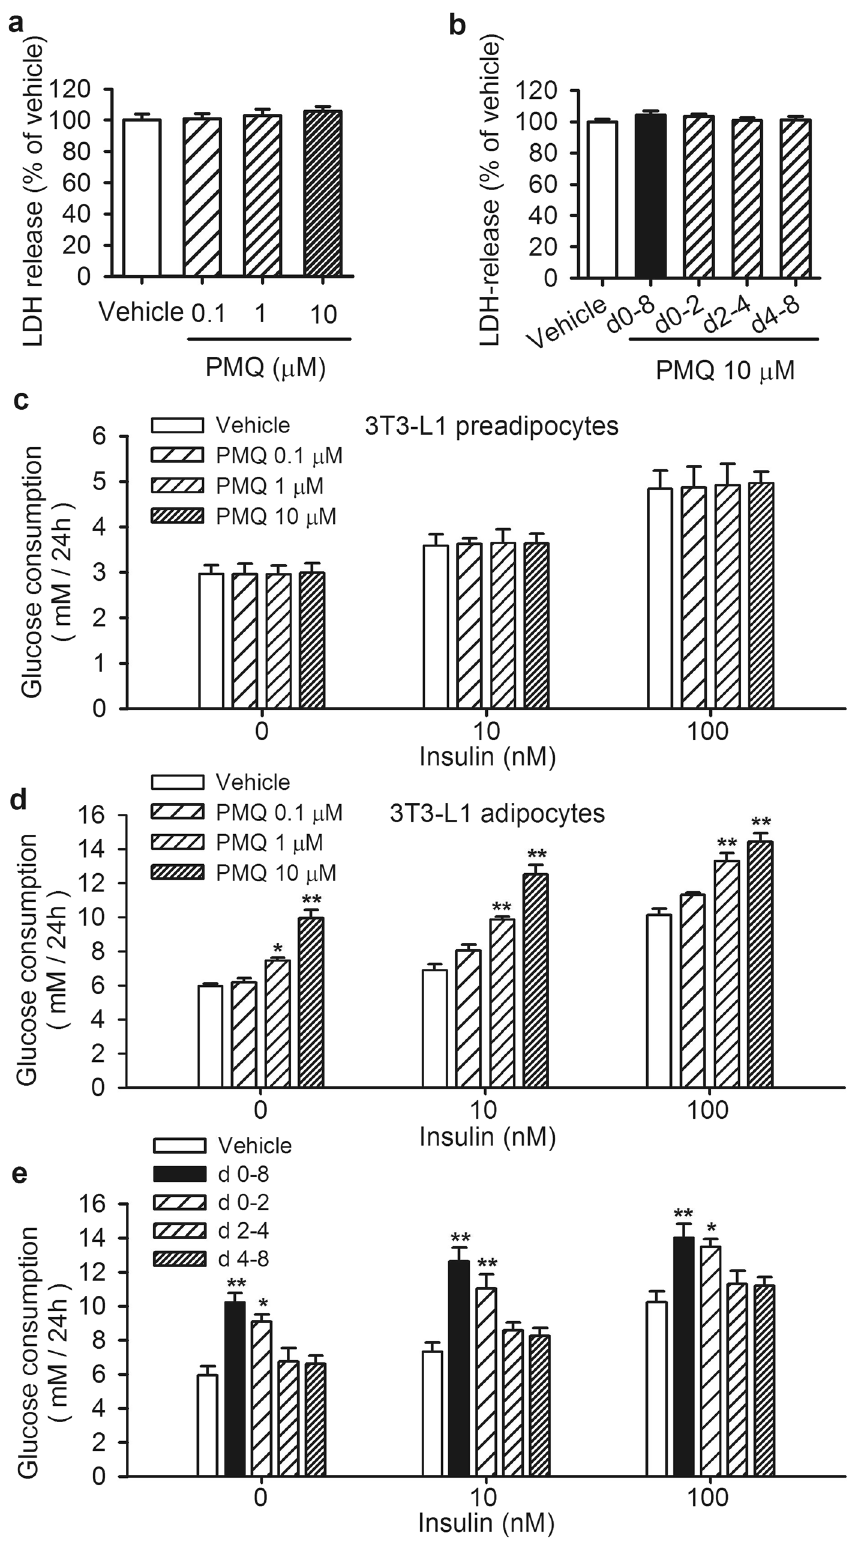
Figure 1. PMQ had no cytotoxic effects and improved glucose metabolism in 3T3-L1 adipocytes. ( a ) 3T3-L1 preadipocytes were treated with PMQ at concentrations of 0.1, 1 and 10 μ M for 72 h. ( b ) During the indicated periods (Days 0–8, 0–2, 2–4, 4–8) of 3T3-L1 adipocyte differentiation, the cells were exposed to 10 μ M PMQ. Cell toxicity was evaluated by LDH release assay on day 8. ( c ) Effects of 0.1, 1 and 10 μ M PMQ on glucose consumption in 3T3-L1 preadipocytes stimulated with or without 10 or 100 nM insulin. ( d ) Cells were incubated with different concentrations of PMQ from Days 0–8. On day 7 of differentiation, the cells with or without 10 or 100 nM